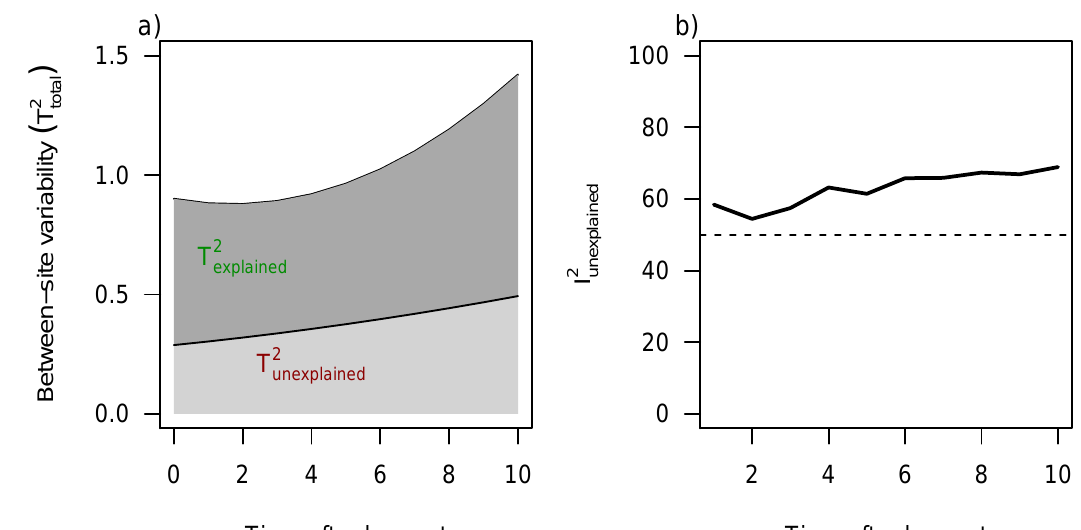
Figure 3. ( a ) Annual between-site variability is partitioned into explained and unexplained heterogeneity. While unexplained heterogeneity linearly increases over the years, heterogeneity explained by the meta-analytical model decreases in the first two years before it increases again after the fourth year. ( b ) Total unexplained variability consists of unexplained between-site and within-site variability. The ratio I 2 is larger than 50 (dotted line), which indicates that between-site variability unexpl = T 2 + S 2 is larger than within-site variability ( I 2 / ( T 2 unexpl unexplained unexplained